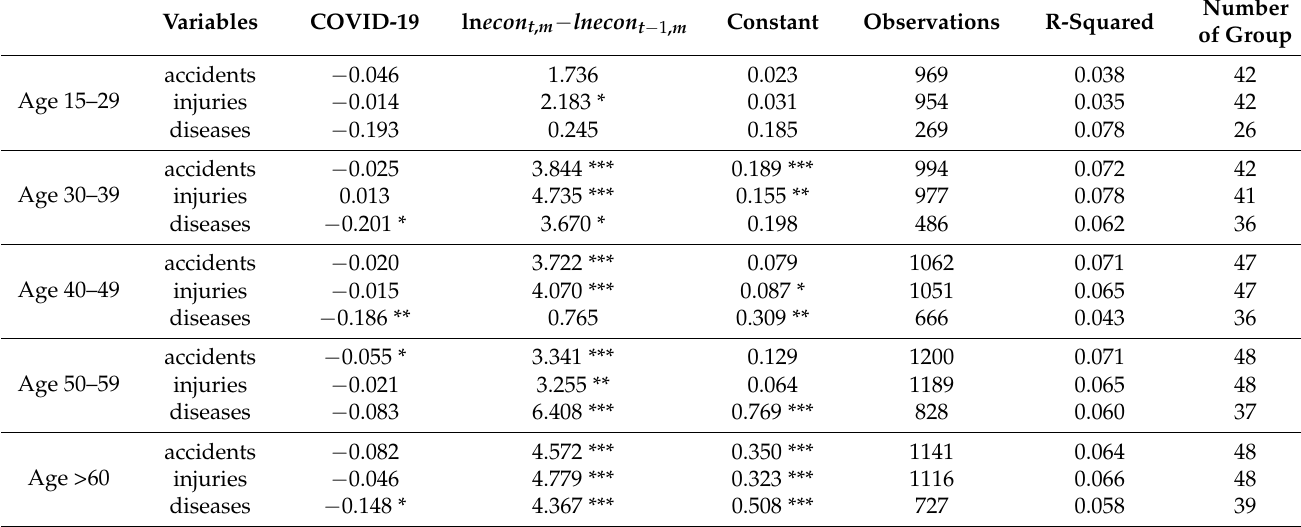
Table 5. Estimation results of fixed effects models by age